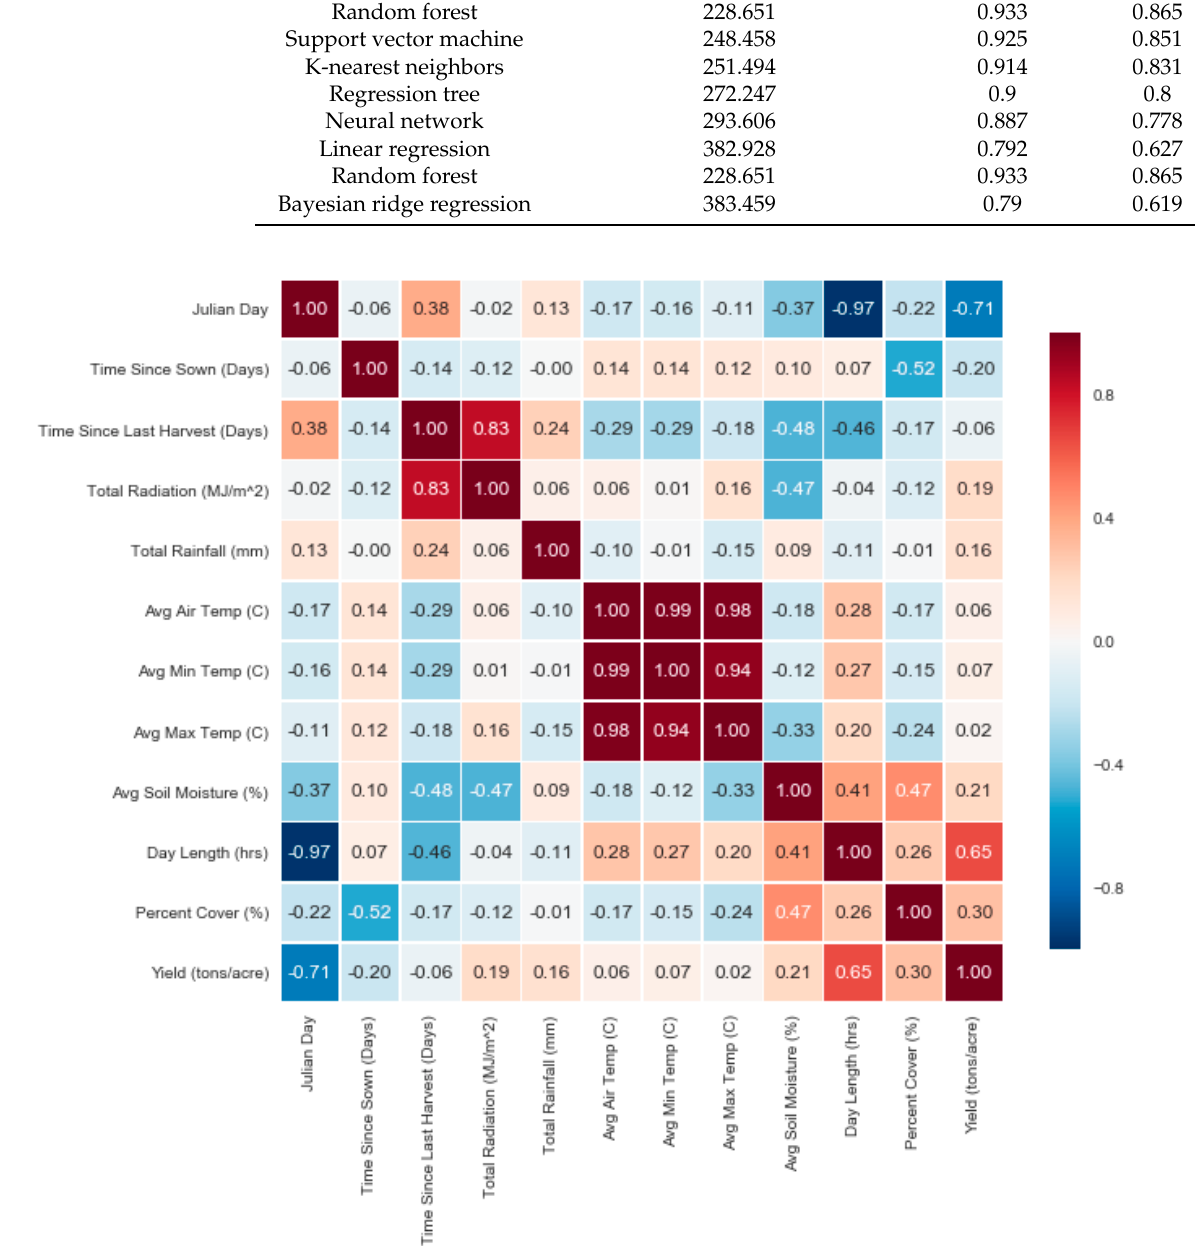
Figure 4. Correlation heat map between features. A heat map showing the value of the correlation coefficient between each possible pair of features. We see higher correlations, positive and negative, between yield and Julian day, time since sown, radiation, rainfall, day length, and others.